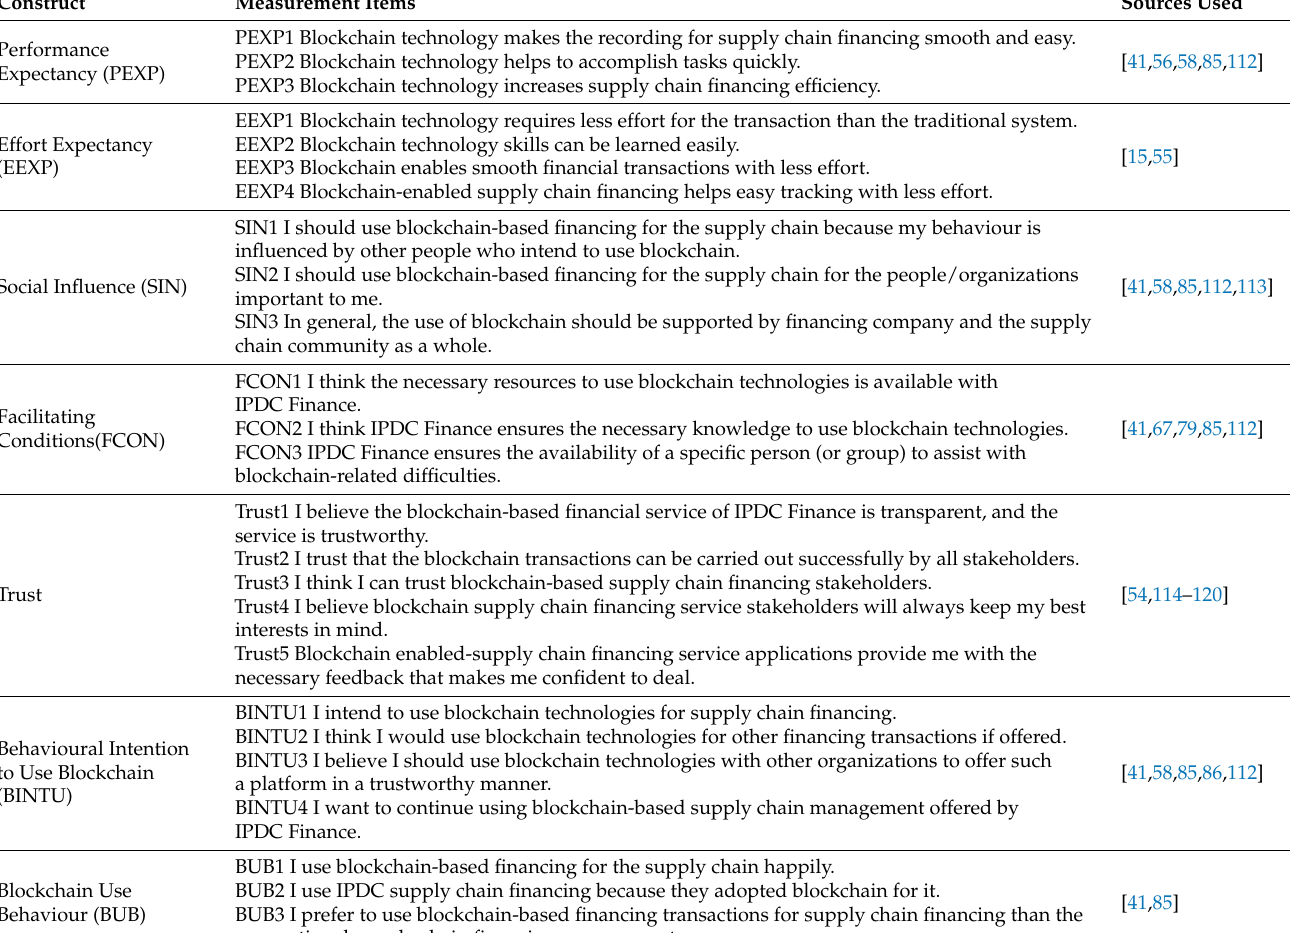
Table 2. Measurement